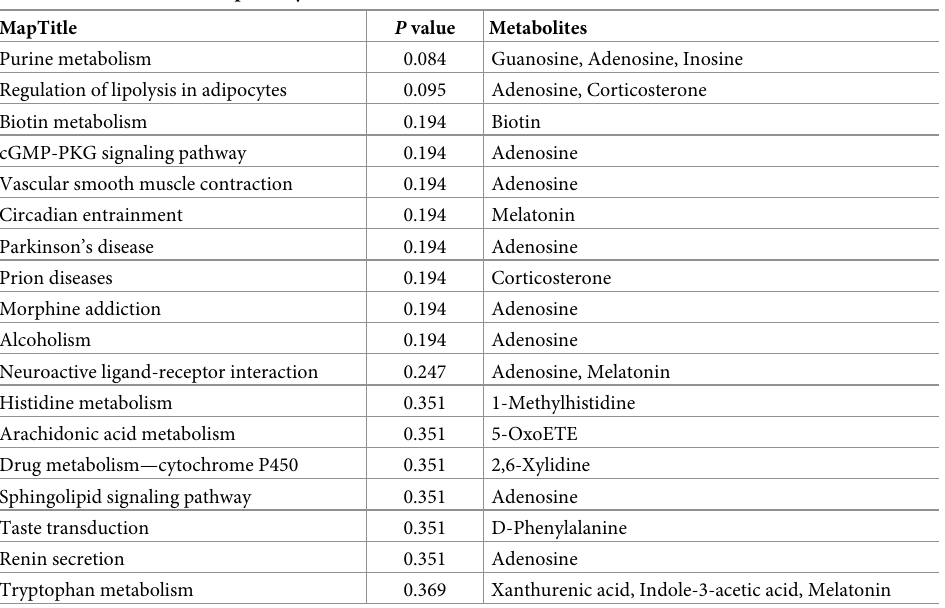
Table 3. Affected metabolic pathways in